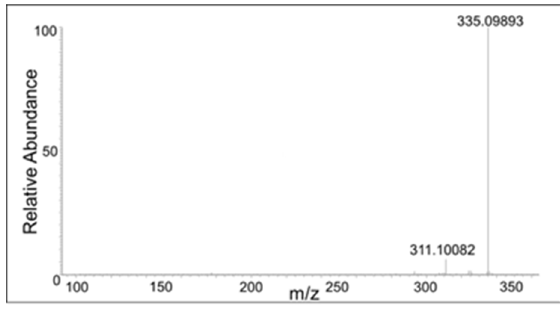
Figure 10. The CID mass spectrum of the m / z 353 mass unit ion eluting at 20 min.